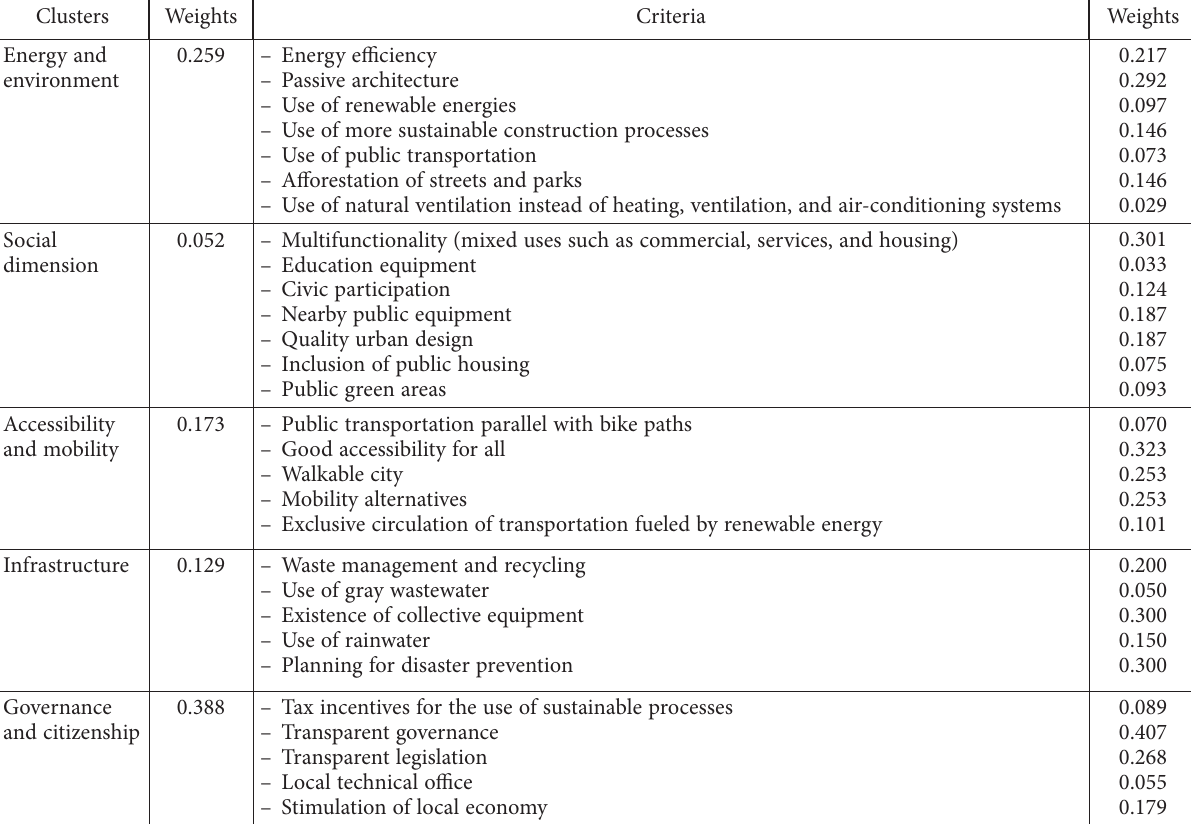
Table 4. Criteria selected for analysis and clusters’ and criteria’s